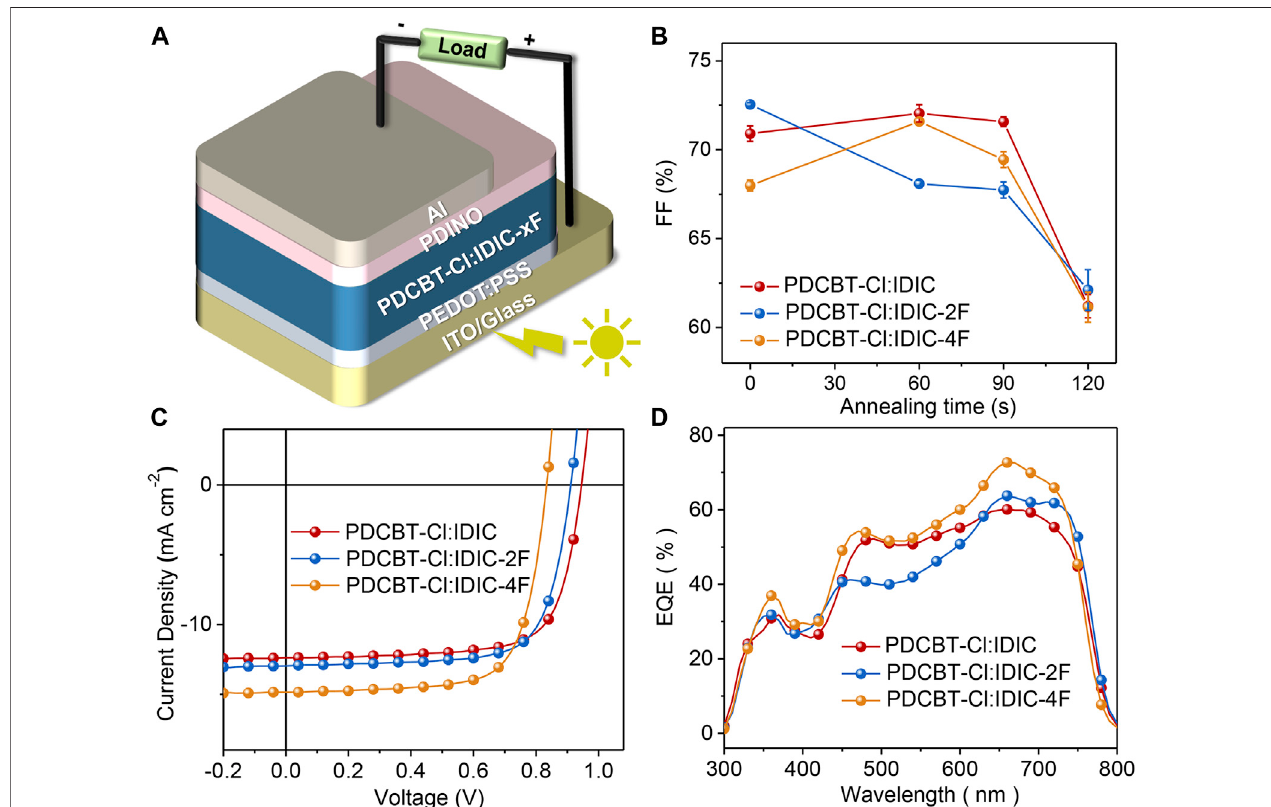
FIGURE3|(A) DevicearchitectureofOSCsbasedonPDCBT-Cl:IDIC-xFblends (B) PlotsofFFasafunctionofsolventvaporannealingtime (C) J-Vcharacteristics and (D) EQE curves of OSCs under the optimized conditions.